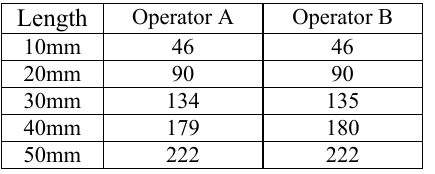
Table 2. Comparison of the measurement result by the Table 3. Comparison of the measurement result by the operator in the length measurement when changing the